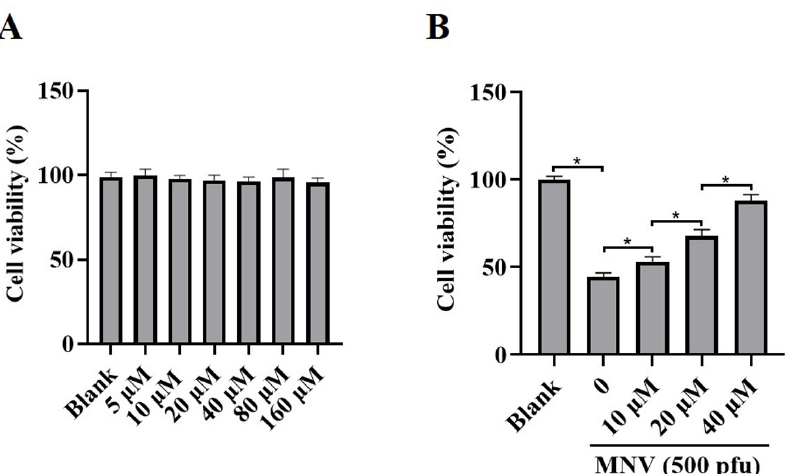
Figure 2. JAT reduces the cytotoxicity of MNV on RAW264.7 macrophages. RAW264.7 macrophages were infected with MNV for 24 h and treated with JAT for 48 h. ( A ) The cell viability of the RAW264.7 macrophages treated with different concentrations of JAT (5, 10, 20, 40, 80, and 160 μM) was detected by CCK-8 assay. ( B ) The cell viability of the MNV-infected RAW264.7 macrophages in the absence or presence of JAT (10, 20 and 40 μM) was detected by a CCK-8 assay. * p < 0.05.